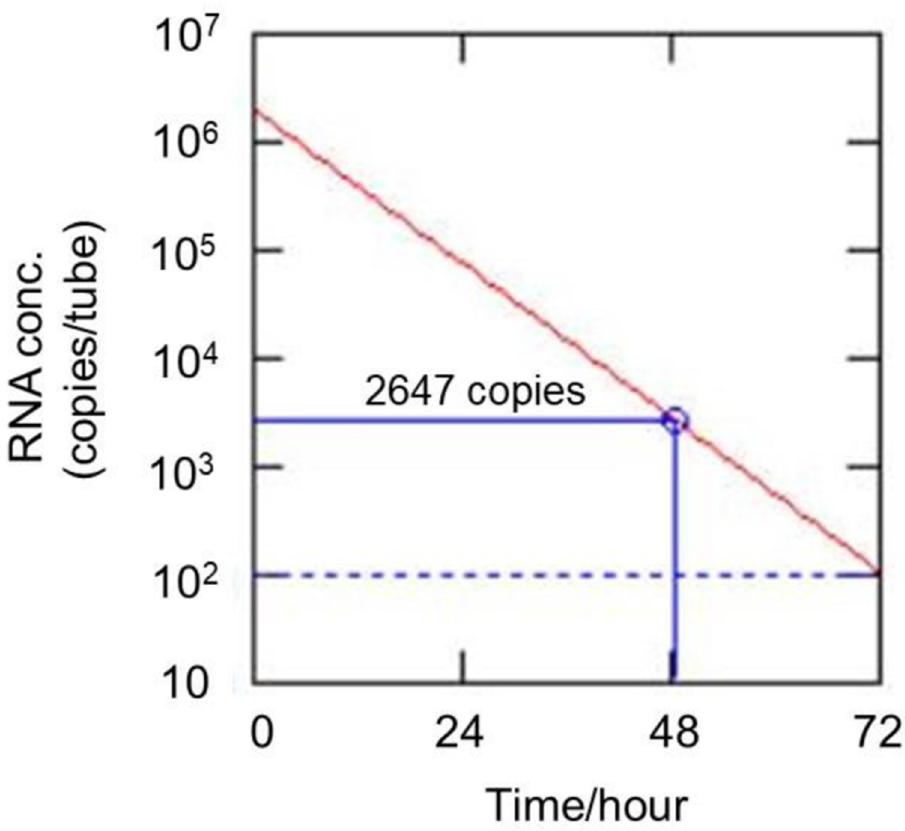
Fig 4. Over-time estimation in which RNA degrades to the detection limit at 25˚C. The dotted line represents the detection limit.